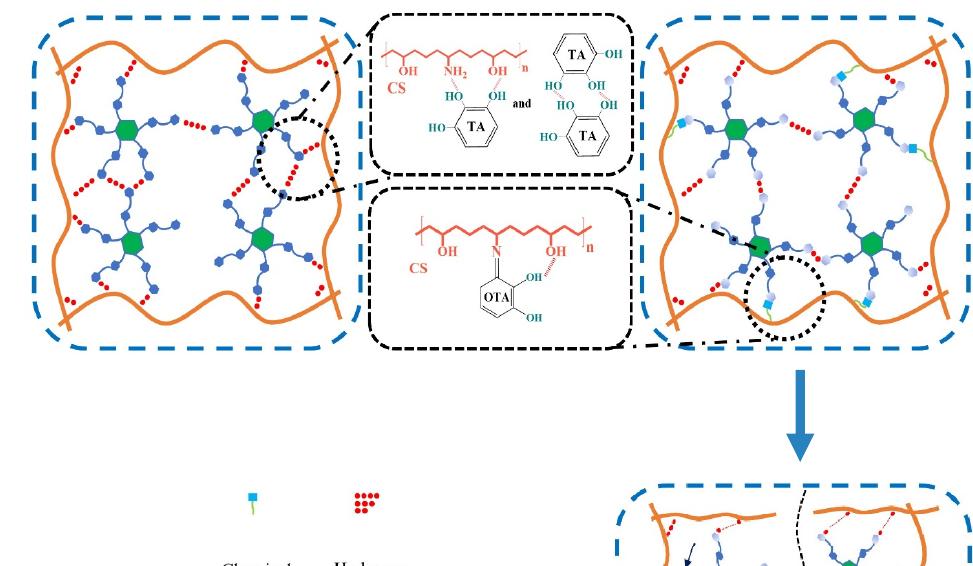
Scheme 1. Schematic diagram of the internal structure of CTA and COTA films.